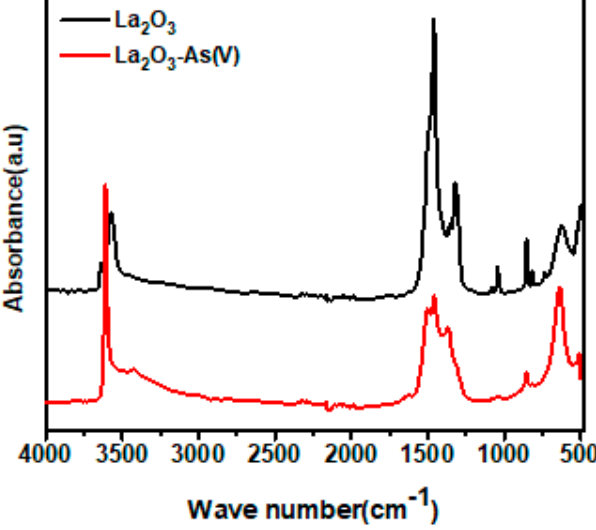
Figure 7. FT-IR spectra of La 2 O 3 nanorods before and after As(V) adsorption.